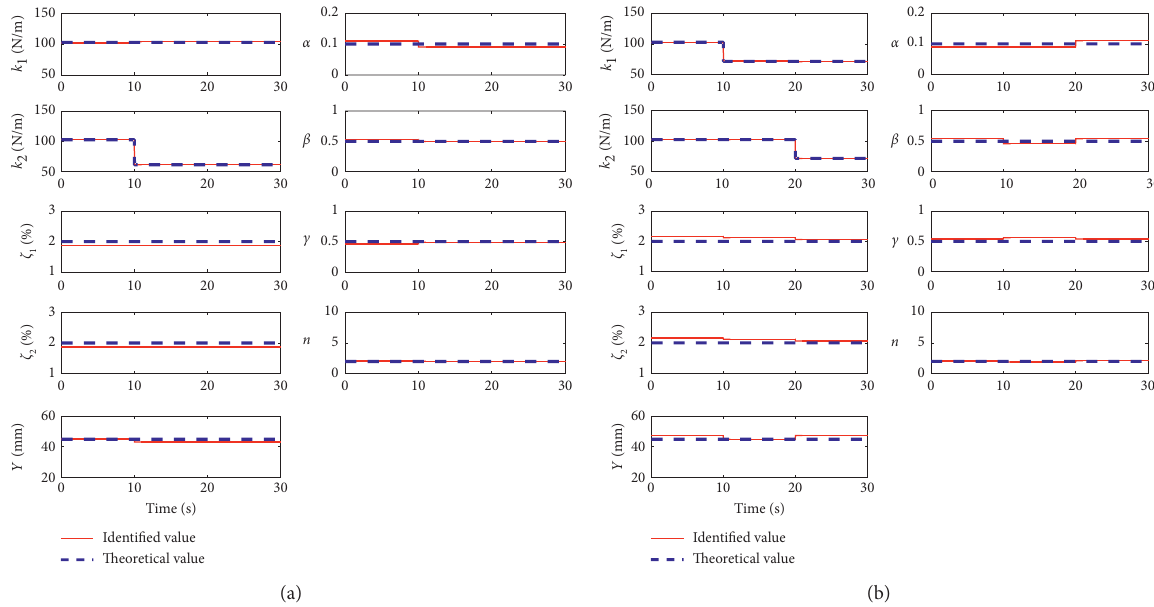
Figure 17: Structural parameters’ identification results when structure is subject to EI-Centro earthquake. (a) Case 1. (b) Case 2.